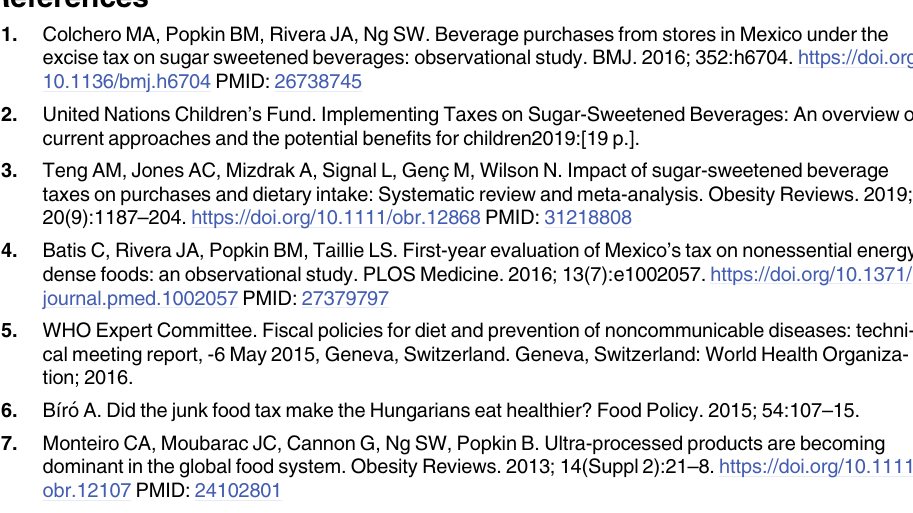
S1 Table. Own, cross price elasticities and income elasticities for food and beverages 2015– 2017 (QUAIDS model). S2 Table. Parameters for revenue